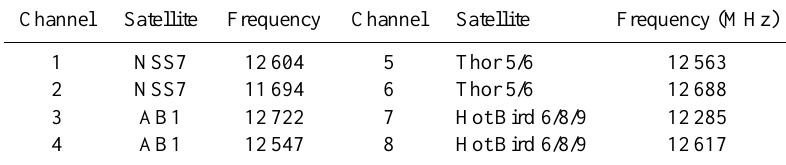
Fig. 3. Experimental setup.